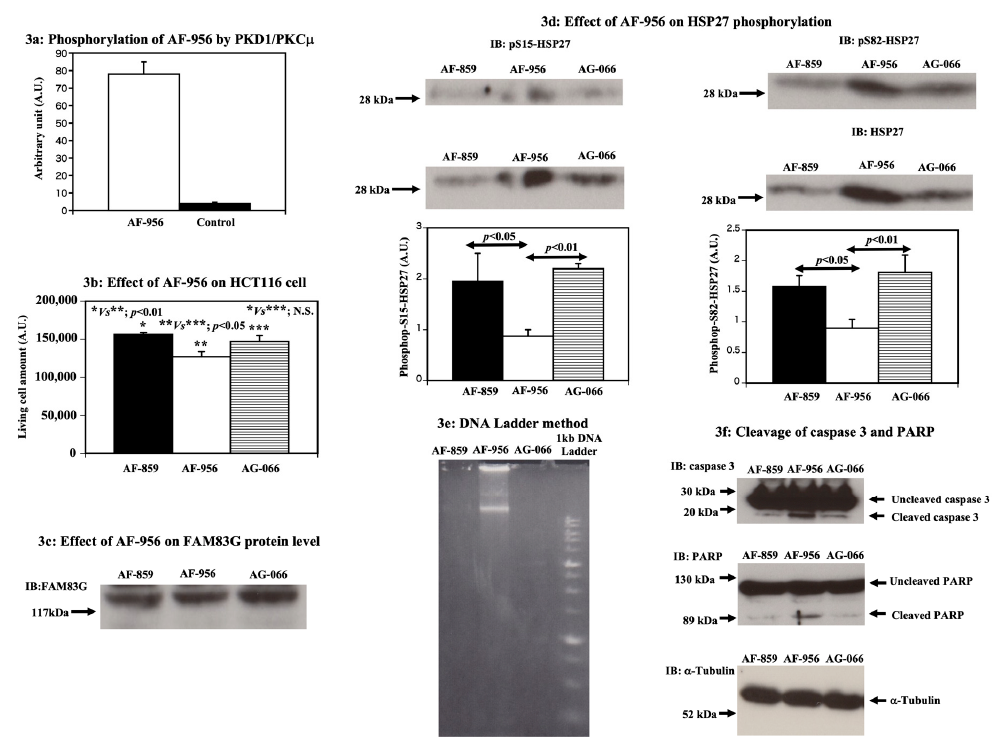
Figure 3. The FAM83G AF-956 peptide activates apoptosis through the reduction of HSP27 phosphorylation in HCT116 cells. ( a ) Phosphorylation of AF-956 by PKD1/PKC μ , An in vitro kinase assay showed that PKD1/PKC μ phosphorylated AF-956. The AF-859 peptide (random peptide) was used as a control. The experiments were independently performed in triplicate. ( b ) AF-956 reduces the live HCT116 cell number, Treatment with 54 μ M AF-956 significantly reduced the live cell number (middle column); treatment with 54 μ M AF-859 (left column) or 54 μ M AG-066 (right column) had no significant effect on cell number. The experiments were independently performed in triplicate. ( c ) AF-956 has no effect on FAM83G protein levels, Immunoblots showing that the peptides AF-859, AF-956, and AG-066 had no effect on endogenous FAM83G protein levels, experiments independently performed in triplicate. ( d ) AF-956 reduces the S15 and S82 phosphorylation of HSP27. Whole cell lysates from HCT116 cells treated with AF-859, AF-956, or AG-066 were analyzed by immunoblotting (IB) with antibodies specific for anti-phospho-(S15) HSP27 (middle panel, left) and anti-phospho-(S82) HSP27 (middle panel, right). IB with an HSP27-specific antibody: AF-956 treatments increased HSP27 protein levels in HCT116 cells relative to AF-859 and AG-066 treatments (top panels, left and right). Bottom panels (bar graphs) show the S15 and S82 phosphorylation of HSP27, i.e., the intensity of the phospho-S15 HSP27 and phosphor-S82 HSP27 bands relative to that of the HSP27 band. The AF-956 treatment (middle bar) of HCT116 cells significantly reduced both the S15 and S82 phosphorylation of HSP27, whereas AF-859 (left bar) and AG-066 (right bar) treatments had no effect. The experiments were independently performed in triplicate. ( e ) AF-956 causes apoptosis in HCT116 cells (DNA Ladder analysis). Apoptotic DNA fragmentation was qualitatively analyzed using the DNA Ladder method. Lanes, from left to right: AF-859-treated cells, AF-956-treated cells, AG-066-treated cells, 1 kb DNA ladder marker. Analysis showed that AF-956-treated cells caused apoptosis. The experiments were independently performed in triplicate. ( f ) AF-956 causes apoptosis in HCT116 cells (cleavage of caspase 3 and PARP proteins). HCT116 cells treated with AF-956 showed increased caspase 3 and PARP protein cleavages. Top panel: levels of cleaved and uncleaved caspase 3 proteins (arrows) following the treatment of HCT116 cells with AF-859 (left lane), AF-956 (middle lane), and AG-066 (right lane). Middle panel: levels of cleaved and uncleaved PARP proteins (arrows) following the treatment of HCT116 cells with AF-859 (left lane), AF-956 (middle lane), and AG-066 (right lane). Bottom panel: α -tubulin IB shows equivalent protein loading in each lane. The experiments were independently performed in